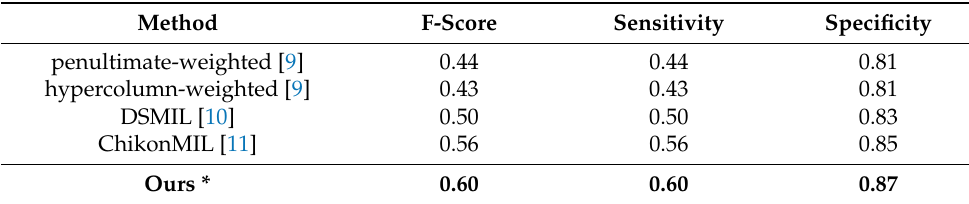
Table 7. Comparison of baseline methods with our best model (WSI + EPN + DMN-M). Method F-Score Sensitivity Specificity penultimate-weighted